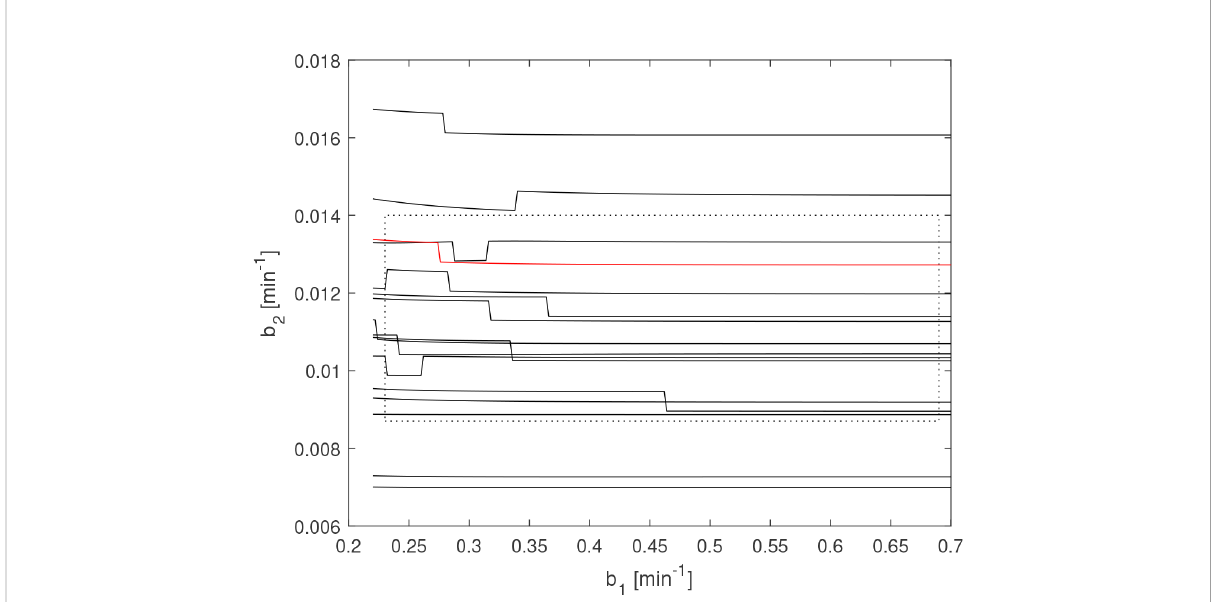
FIGURE 4 Estimated g P for LH-data from 15 healthy males (solid black lines), one female (solid red) and the theoretical parameter ranges (dotted box) given in